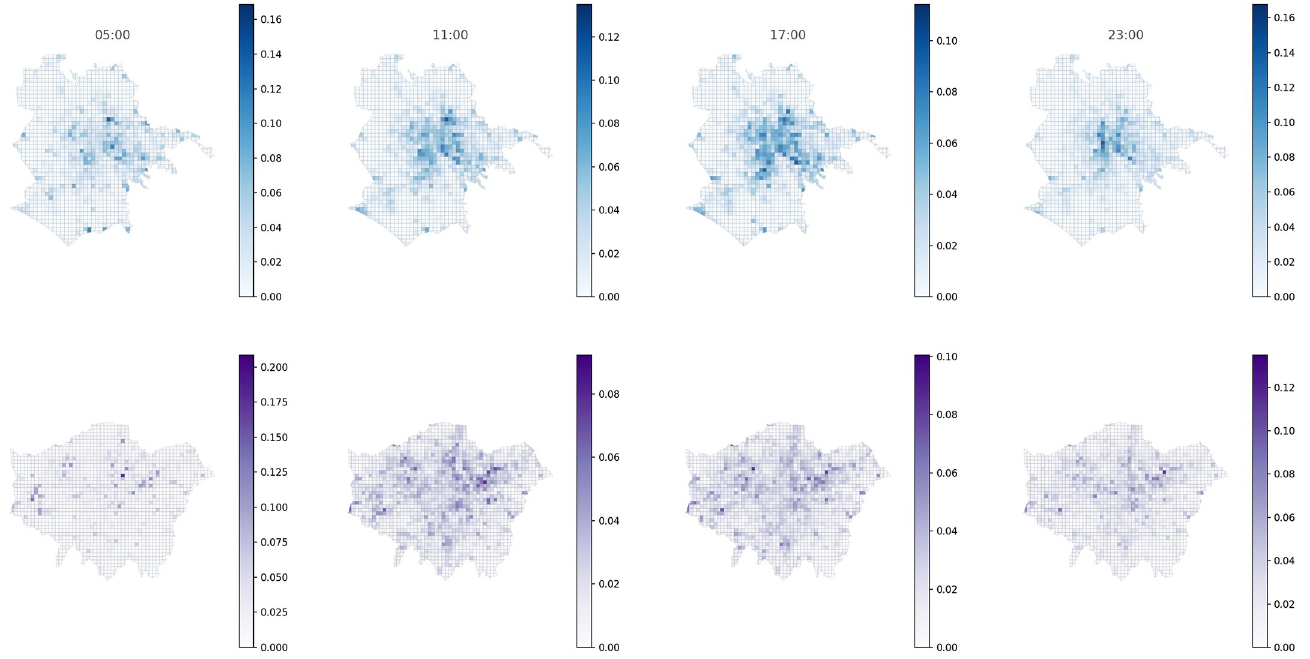
Fig 4. The APA values for the mobility flow network in Rome (up row) and London (down row) at different times of the day.